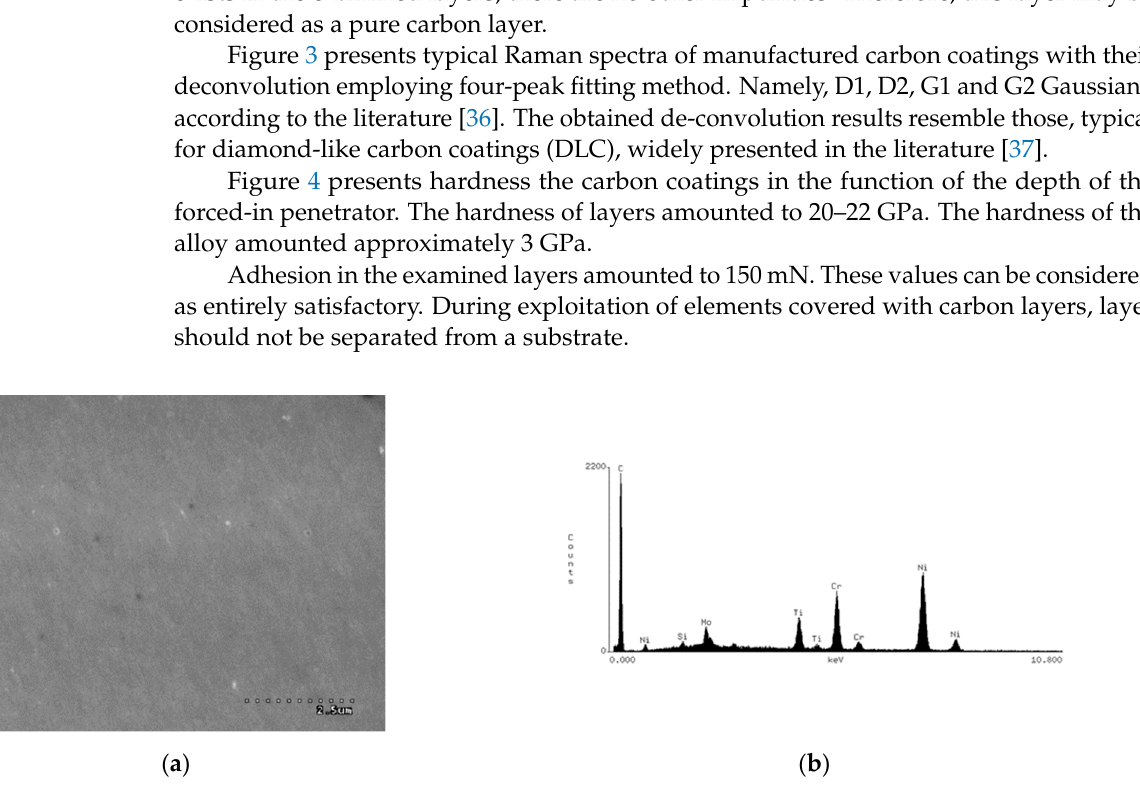
Table 2. Chemical composition of artificial saliva solution.